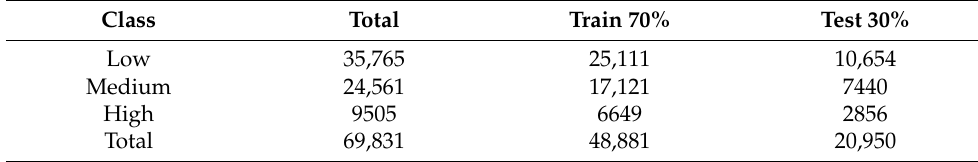
Table 3. Description of classes for experimental datasets.